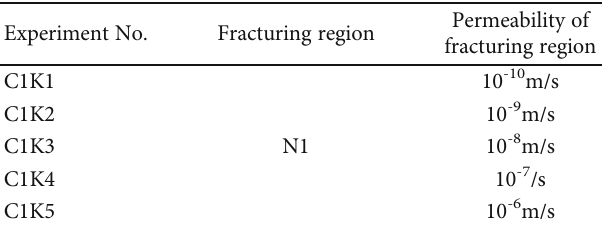
Table 6: Numerical experiments according to di ff erent permeability of the fracturing region. Experiment No.